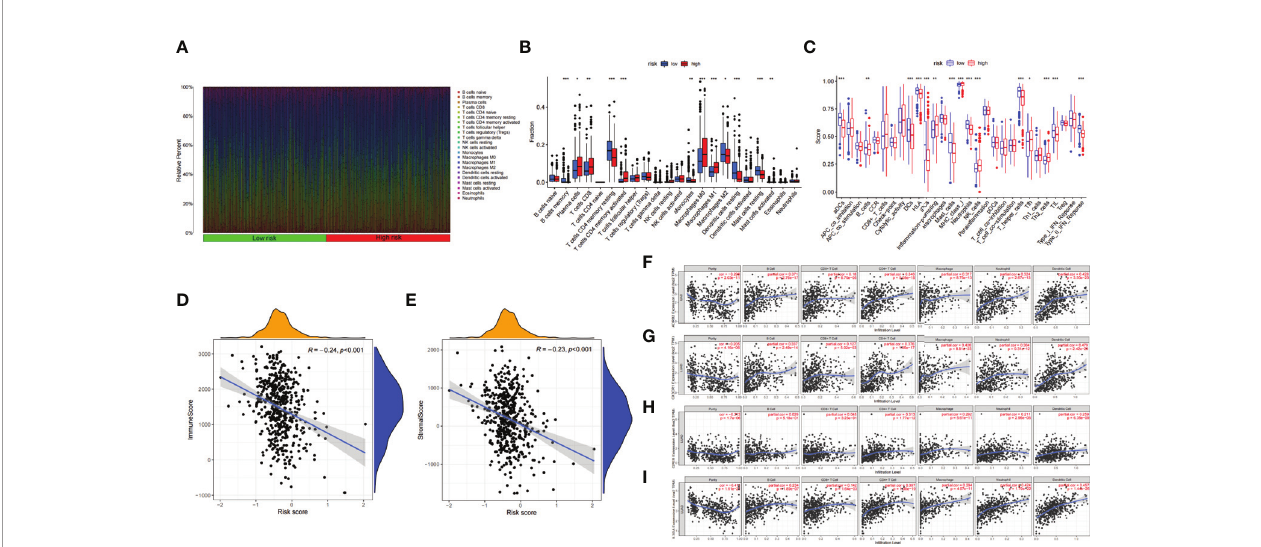
FIGURE 7 | (A) Bar plot presents the distribution of 22 kinds of TICs in LUAD tumor samples. Column names represent sample ID. (B) Bar plot presents the difference of TICs between the high- and low-risk groups. (C) Bar plot presents the difference of immune-related function between the high- and low-risk groups. (D, E) Association between tumor immune microenvironment (TIME) and risk score. (D) ImmuneScore; (E) StromalScore. (F, I) TIMER: Immune correlation analysis of SCIRGs in the model based on immune in fi ltration, (F) ADRB2 , (G) CX3CR1 , (H) GPER ( GPER1 ), and (I) IL3RA. *p < 0.05, **p < 0.01, ***p < 0.001.